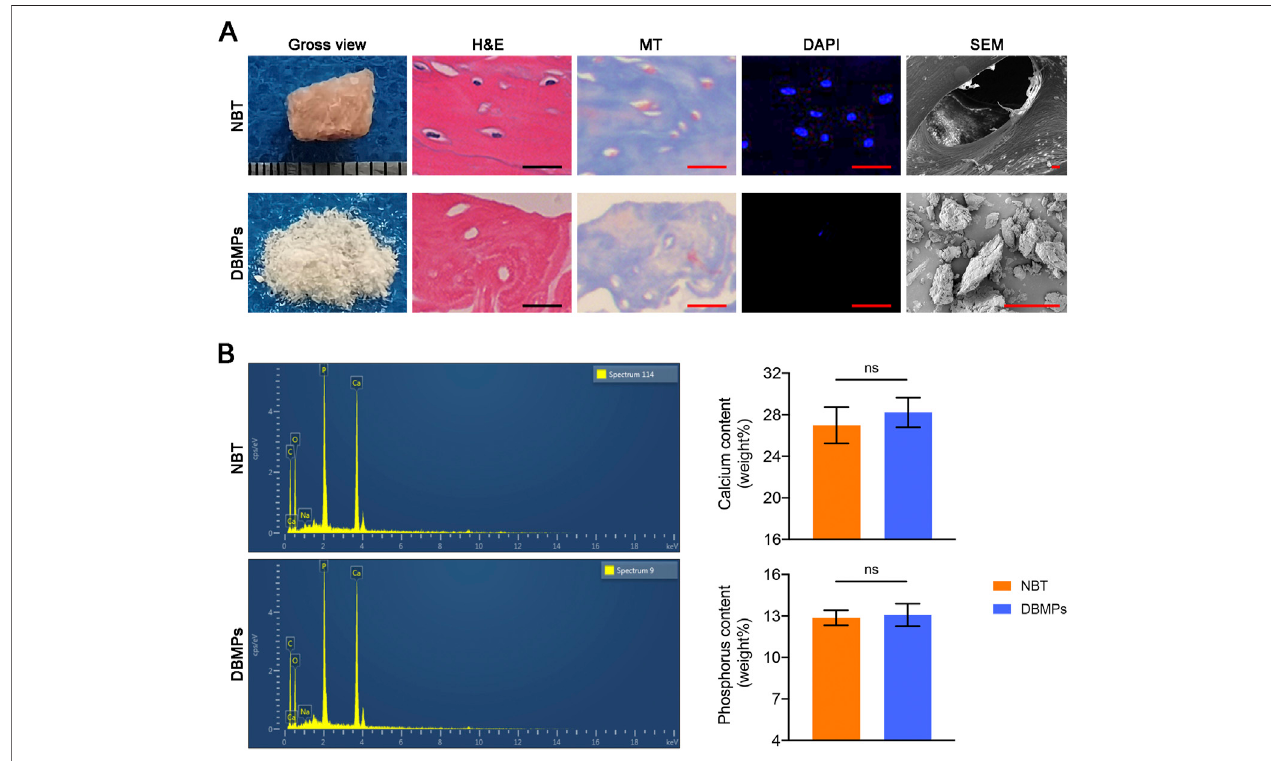
FIGURE 2 | (A) Gross observation, H&E staining, MT staining, DAPI staining, SEM of the native bone tissue (NBT), and decellularized bone matrix powders (DBMPs). Bar = 10 μ m. (B) Contents of calcium (Ca) and phosphorus (P) in the DBMPs and NBT evaluated by EDX. n = 4 for each group. Data are showed as means ± standard deviation (* p < 0.05, ** p < 0.01, and *** p <